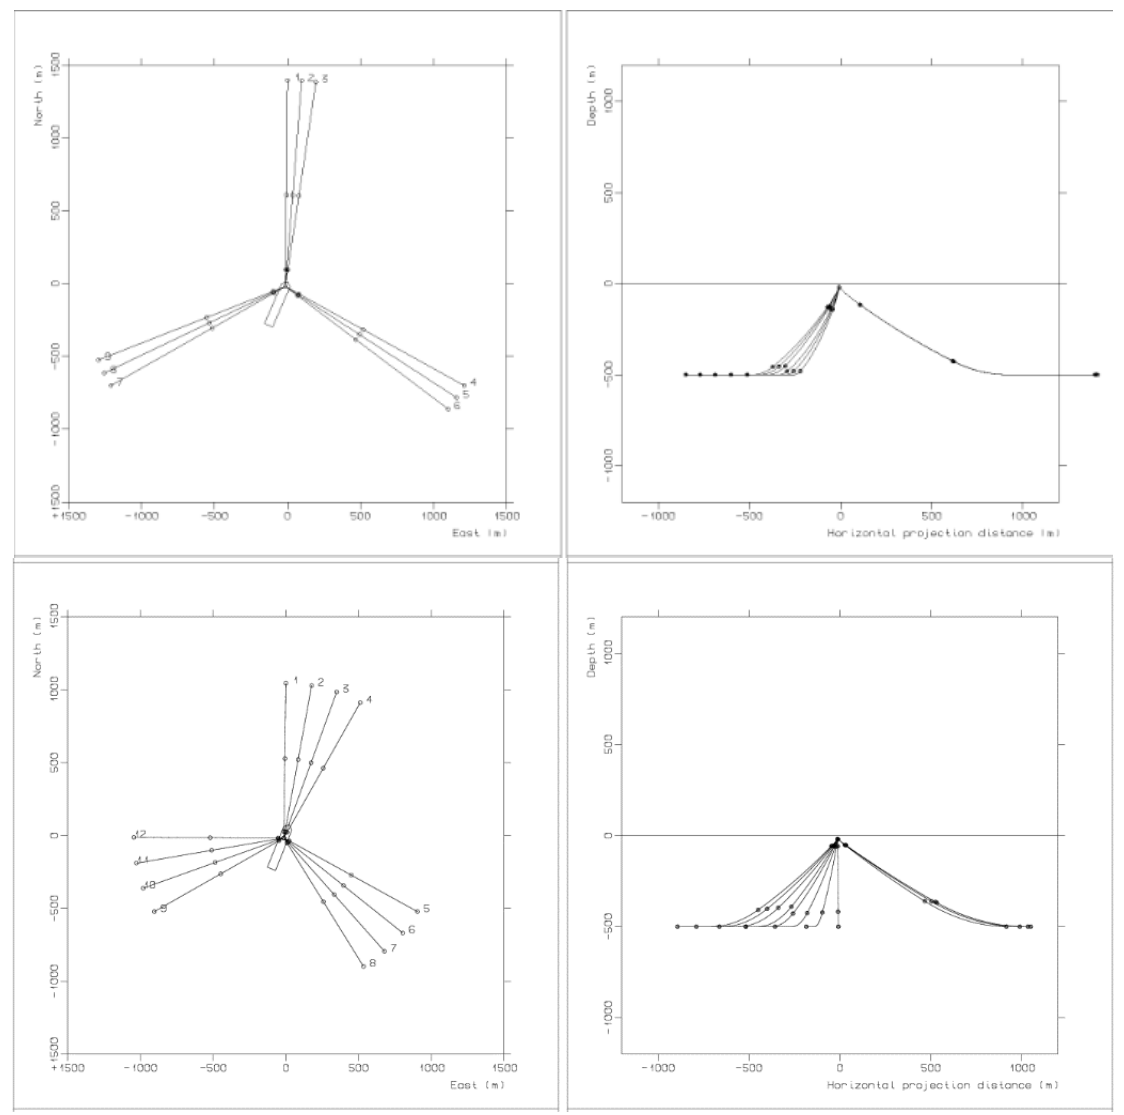
Figure 7. Initial ( top ) and optimized ( bottom ) mooring configuration for Case B.